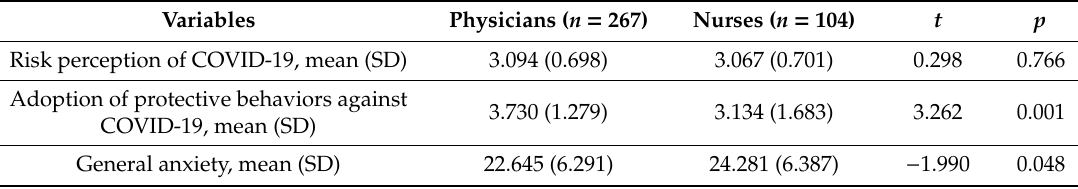
Table 4. Comparisons of Risk Perception, Adoption of Protective Behaviors, and Levels of General Anxiety between Physicians and Nurses Who Provided Direct Medical Care to Patients with COVID-19: t